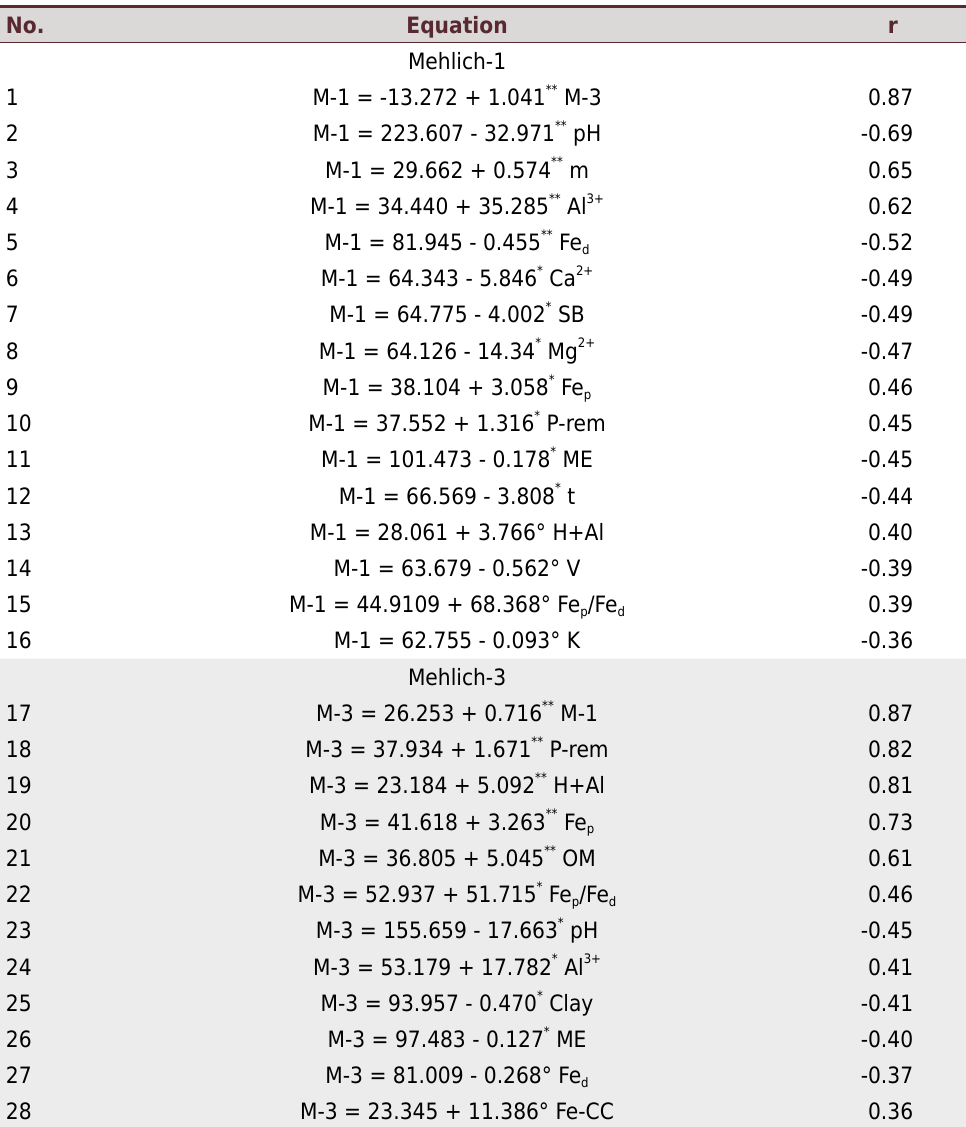
Table 4. Correlation between Fe concentrations obtained by Mehlich-1 (M-1) and Mehlich-3 (M-3) and the individualized properties of the soil